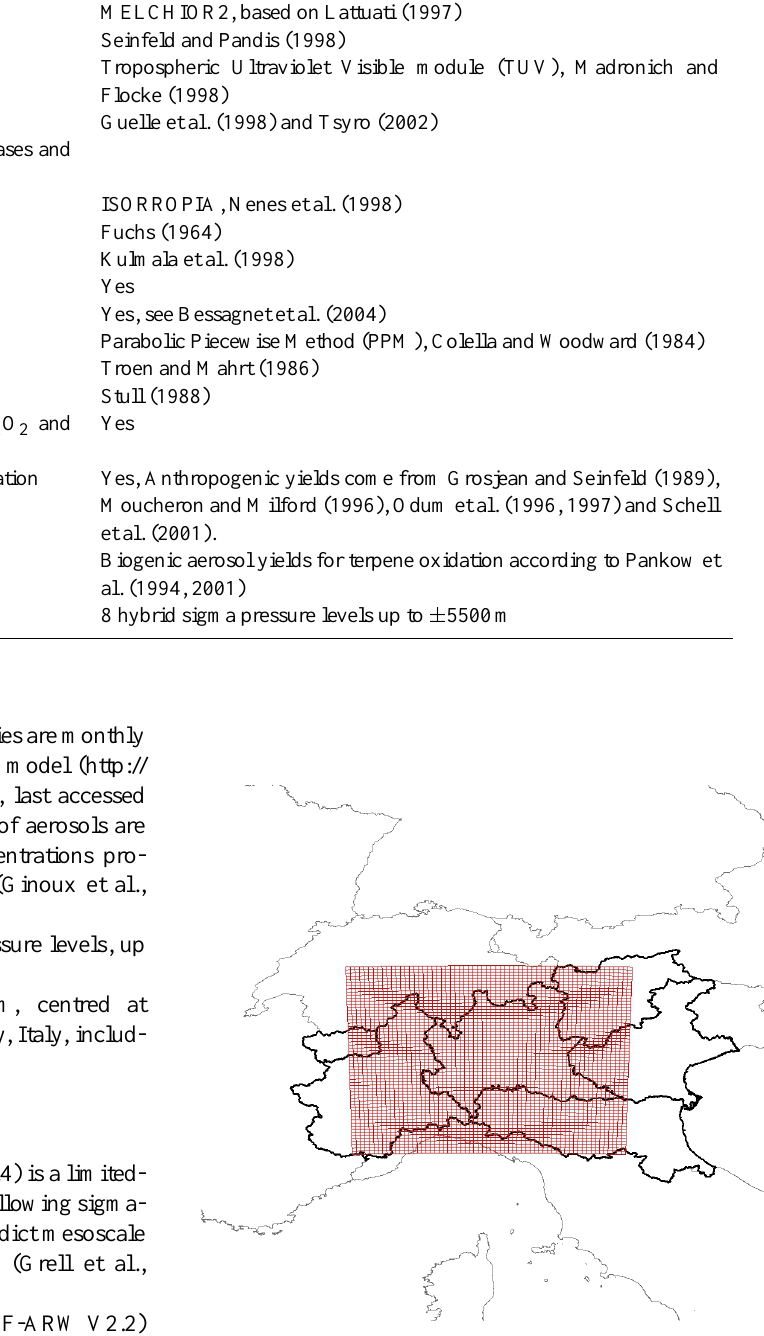
Fig. 1. Map of the location of the model domain in North Italy (centred at 45.0 ◦ N, 10.0 ◦ E), which covers most of the Po valley, including southern part of the